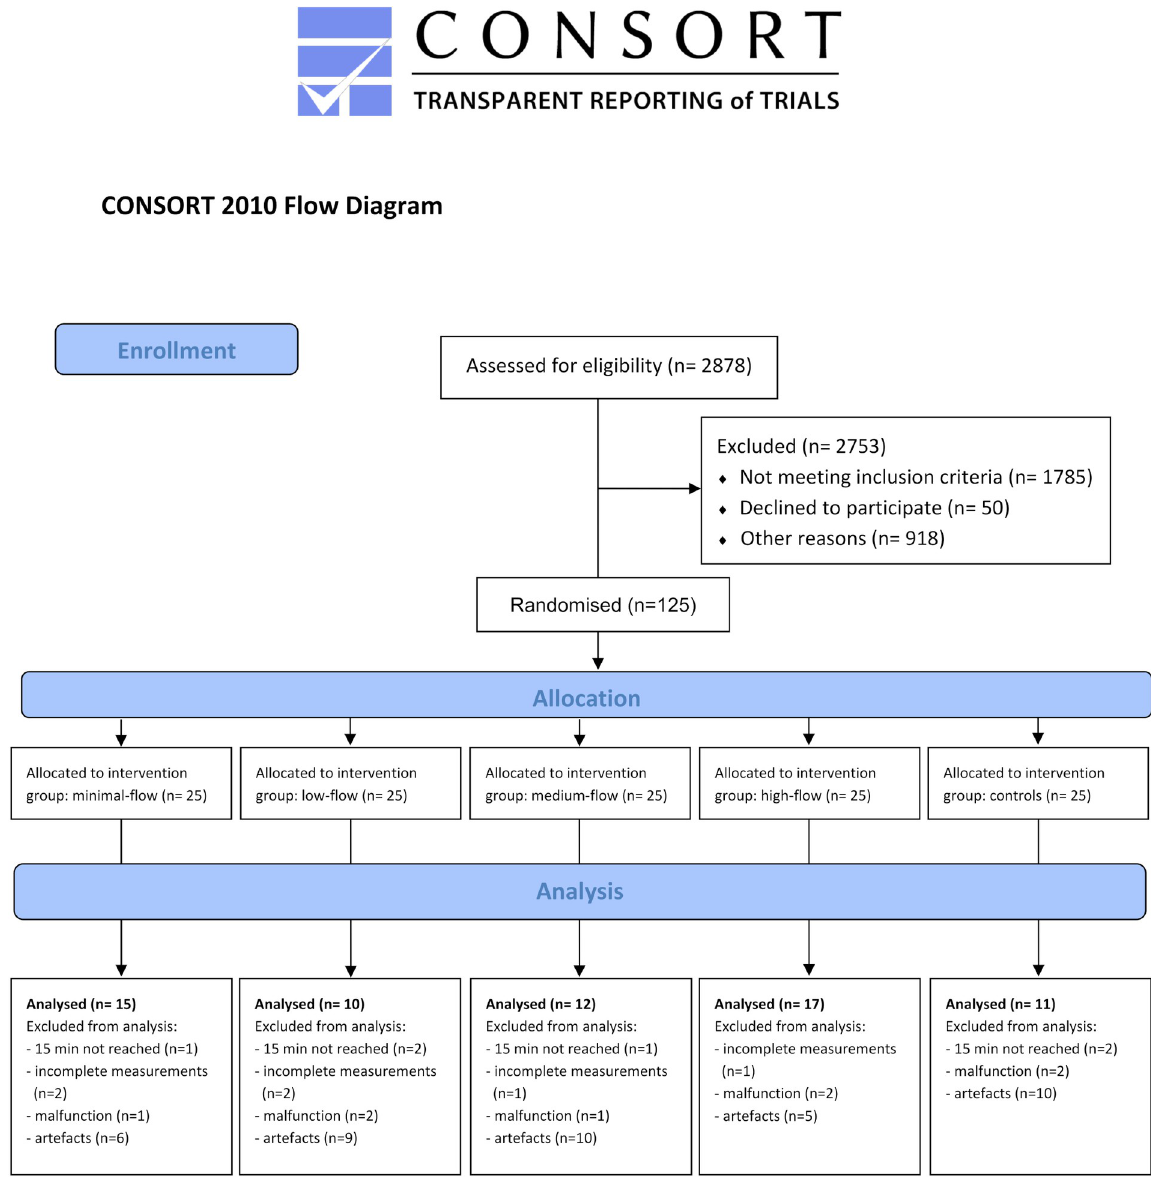
Fig 2. Consolidated standards of reporting trials flow